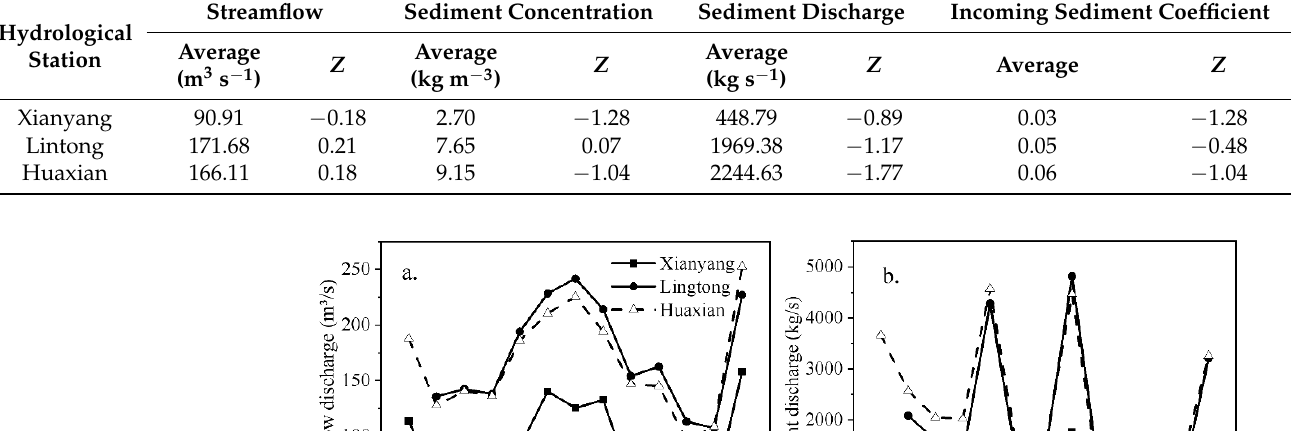
Table 2. Average streamflow-sediment indexes of hydrological stations in the lower Weihe River in 2006–2018.